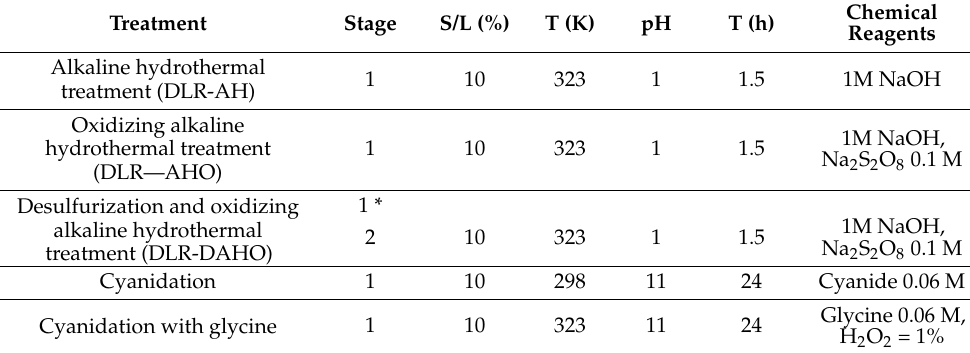
Table 1. Experimental conditions of the treatments applied to the DLR.